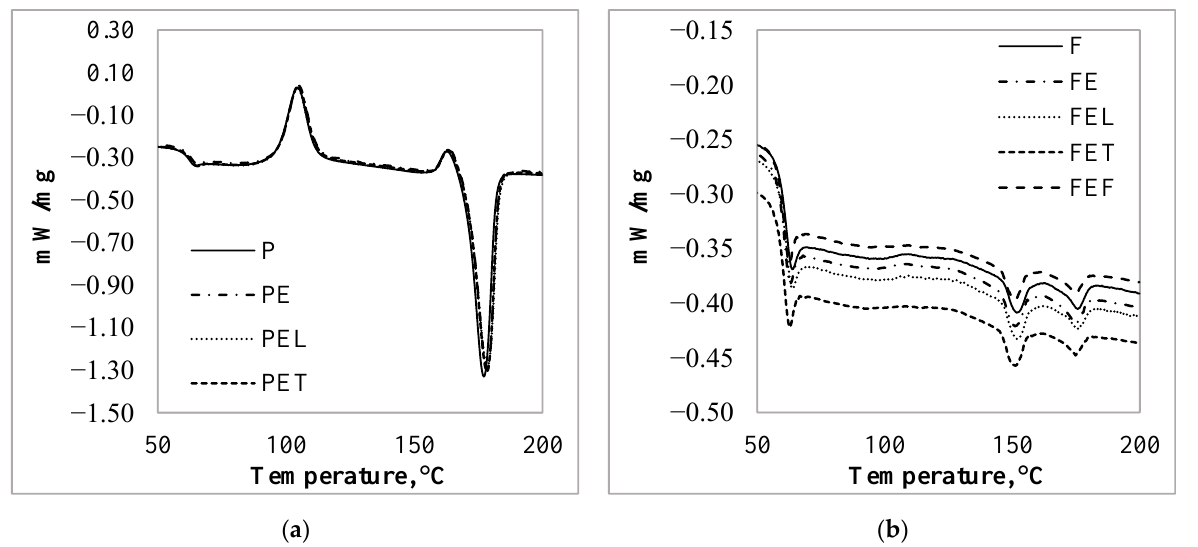
( b ) Figure 7. PLA microparticles first heating DSC curves after the adsorption measurement: ( a ) 3D850